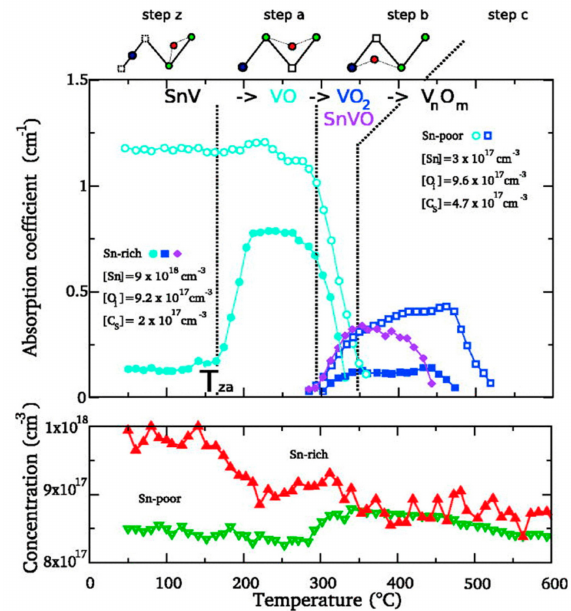
Figure 5. The thermal evolution of the VO (cyan circles), VO 2 (dark blue squares), and SnVO (magenta diamonds) defects for poorly Sn-doped (open symbols) and highly Sn-doped (solid symbols) Si. The upper part is a schematic representation of the defects using blue and green circles for the Sn impurity and Si atoms, square and dotted squares for the V and semi-vacancy, and red circles for the oxygen interstitials. The bottom part is the thermal evolution of the oxygen interstitials for Sn-poor (open triangle) and Sn-rich (solid triangle) conditions. Reproduced with permission from [39]. American Institute of Physics,